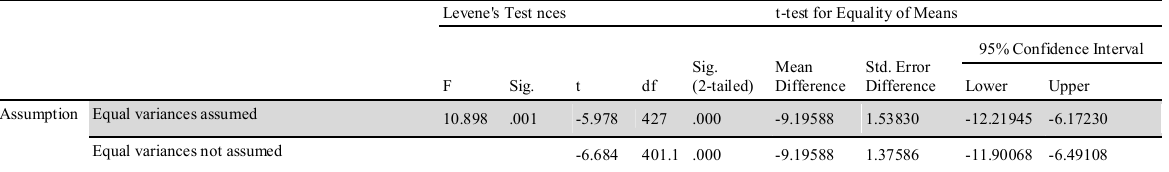
The summary of testing the effect of gender